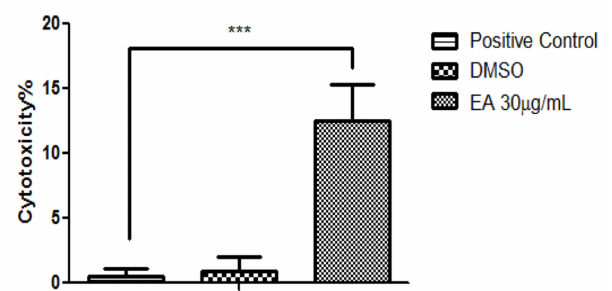
Figure 3. The cytotoxicity analysis of EA extract at a concentration of 30 µ g/mL on MCF-7 cells (after 72 h of